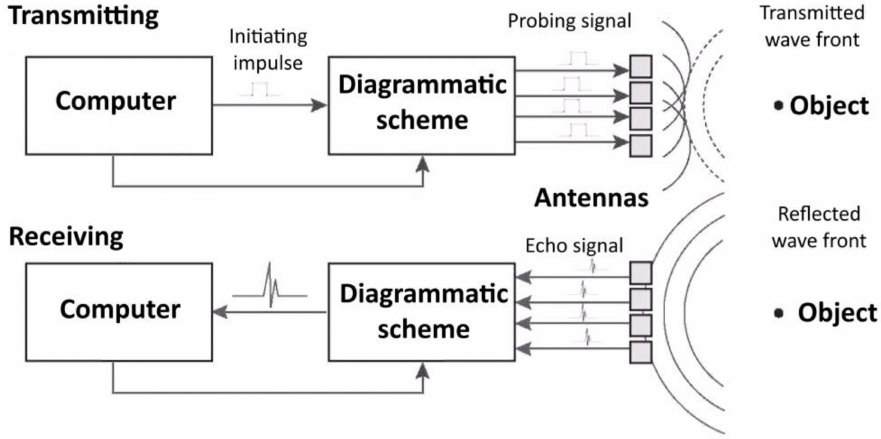
Figure 16. One of the variants of non-destructive testing equipment.